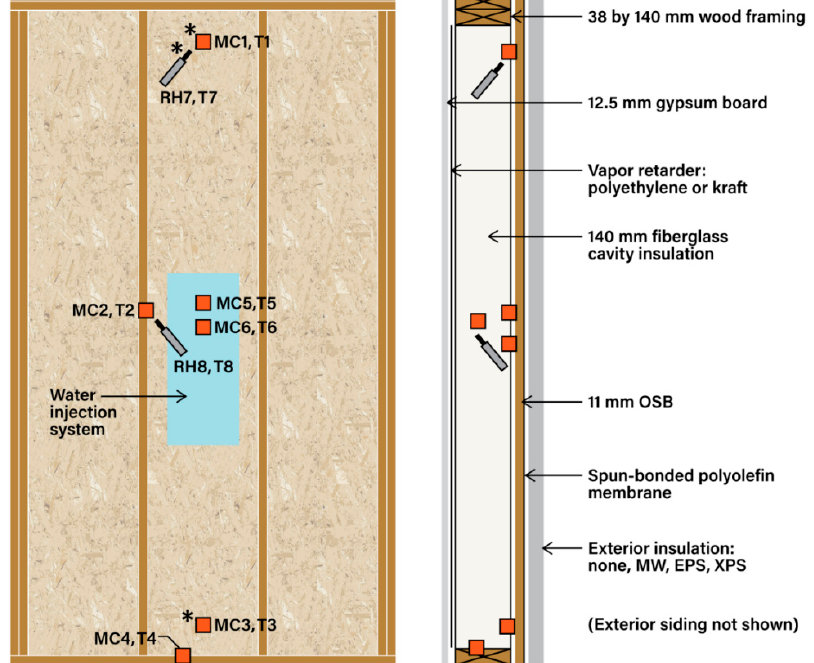
Figure 2. Sensor locations in wall cavity and wall cross section. Probes marked with * were compared to hygrothermal simulation. MC = Moisture Content, T = Temperature, RH = Relative